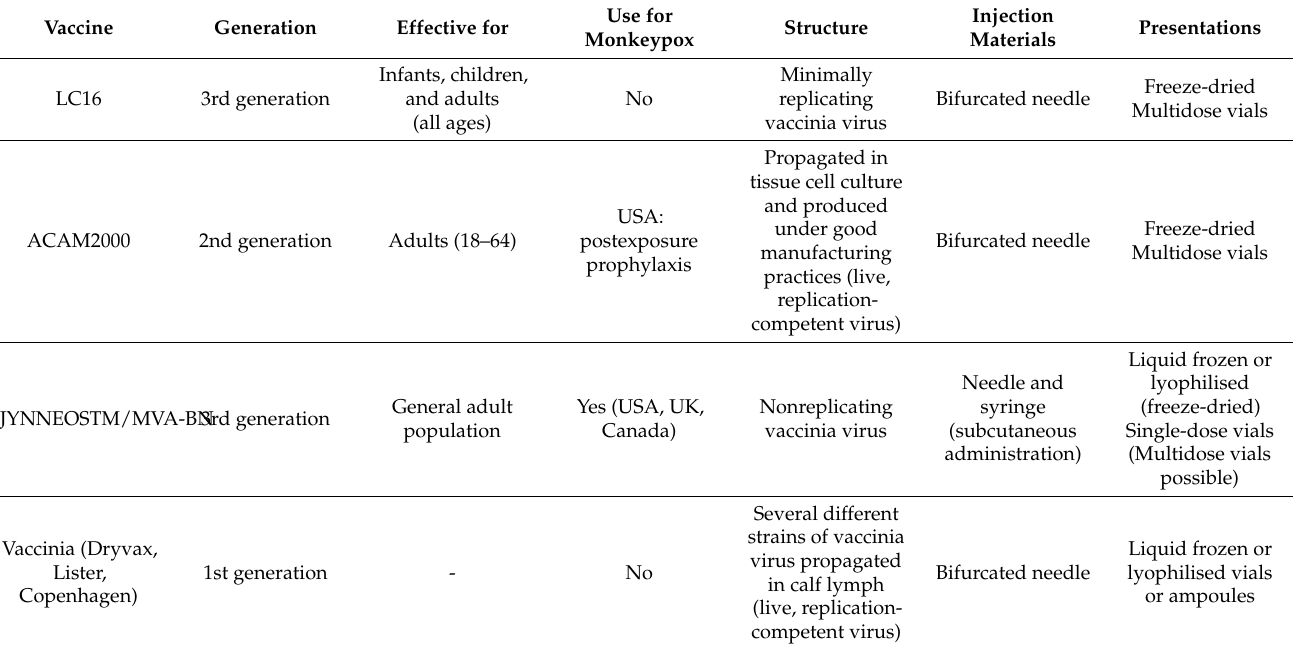
Table 2. Structures, generations, and effectiveness of reported smallpox vaccines for preventing monkeypox